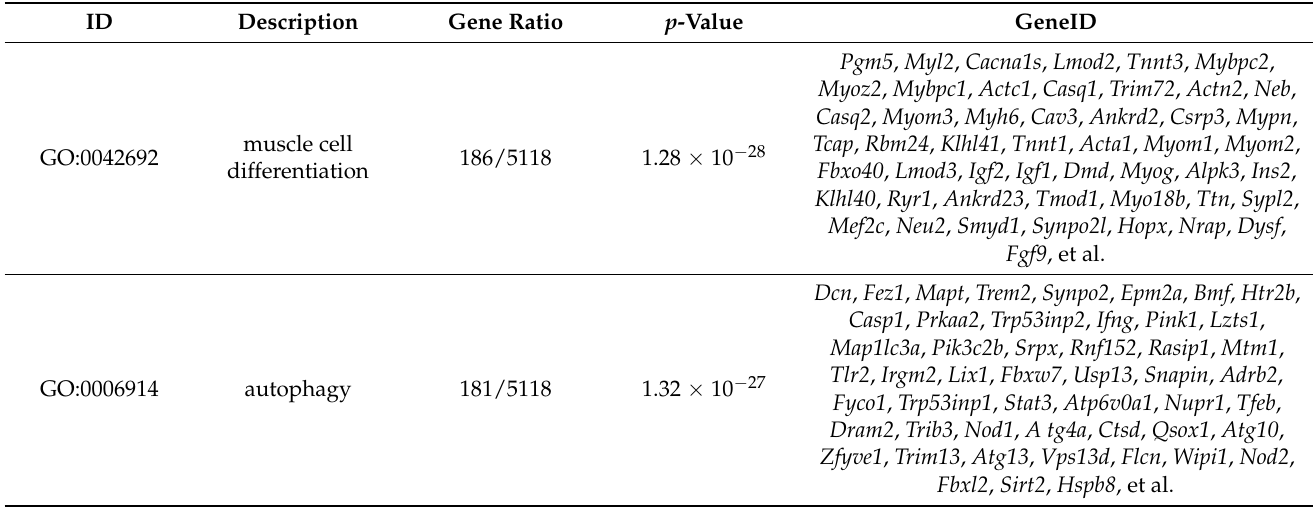
Figure 2. Top 10 biological processes, cellular components, and molecular functions associated with genes upregulated ( A ) and downregulated ( B ) during myoblast differentiation. The X -axis indicates the functional terms, and the Y -axis indicates the number of genes linked to each functional term. In each functional category, terms are ranked from left to right according to their adjusted p -values, with the leftmost term having the smallest p -value. Table 1. Two examples of functional terms associated with genes upregulated during myoblast